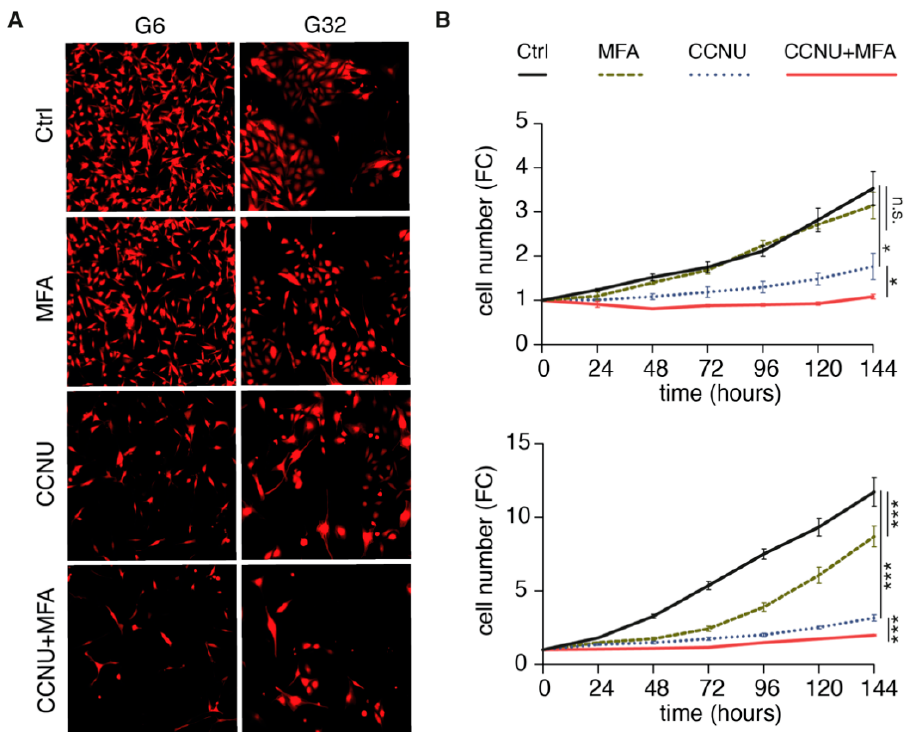
Figure 4. Meclofenamate-induced effects on cell proliferation. ( A ) Representative fluorescence images acquired by the IncuCyte ® S3 Live-Cell Analysis System after indicated treatment for 144 h of the G32 (upper panel) and the G6 (lower panel) cell populations. ( B ) Quantification of cell number from fluorescence images obtained in a 24-h interval over a period of 144 h. Mean ± SEM is depicted. * and *** denote p < 0.05 and p < 0.001. CCNU, lomustine; FC, fold change; MFA, meclofenamate.